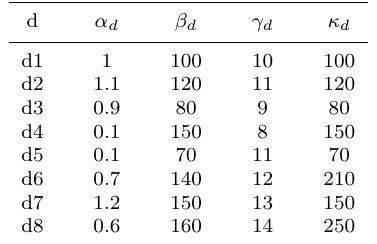
Table 1. Parameters of the cost functions in the transport equilibrium problem. d α